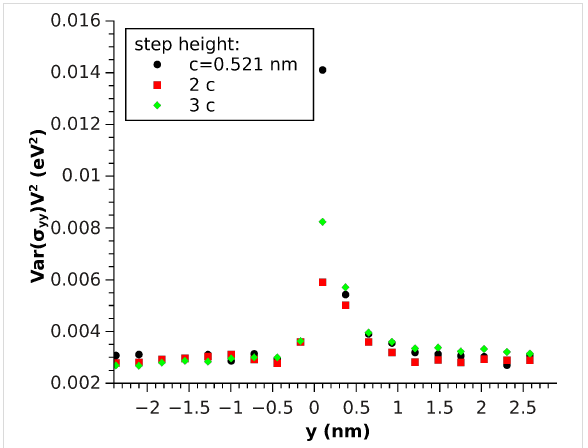
Figure 2: Stress fluctuation multiplied by the squared per-atom volume